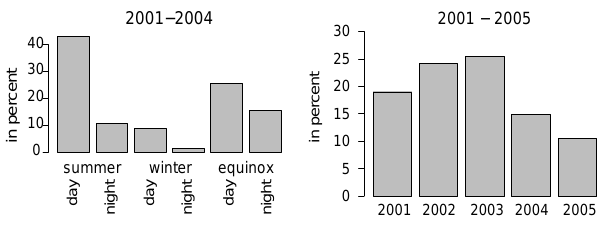
Fig. 5. Occurrence frequency of KSFAC events as a function of season and day/night (a) , and as a function of time during our ob- servation interval (b) . The numbers are normalised to the number of auroral zone crossings.